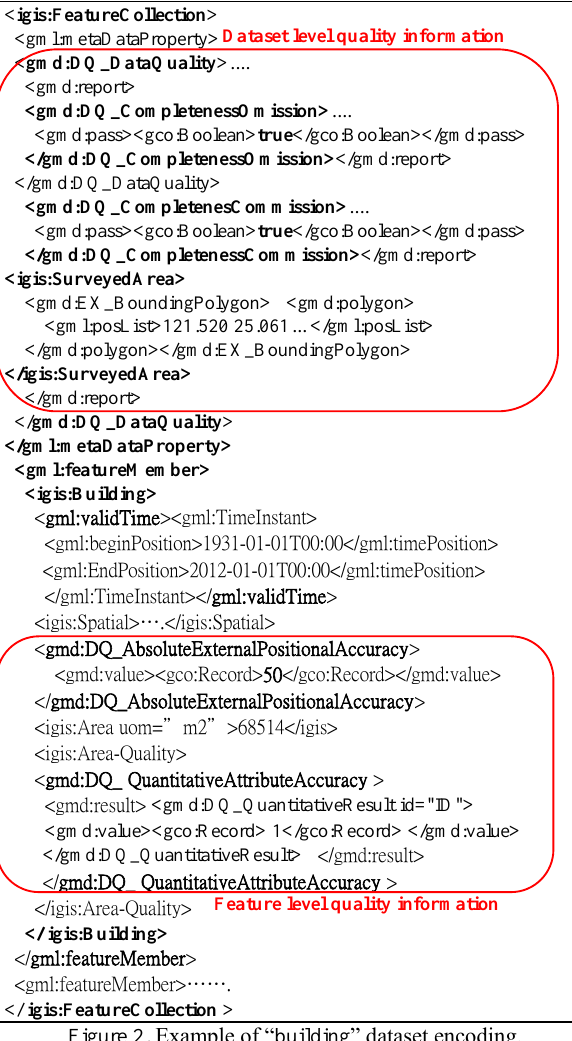
Figure 1. Relationship between basic GIS operations and quality elements.